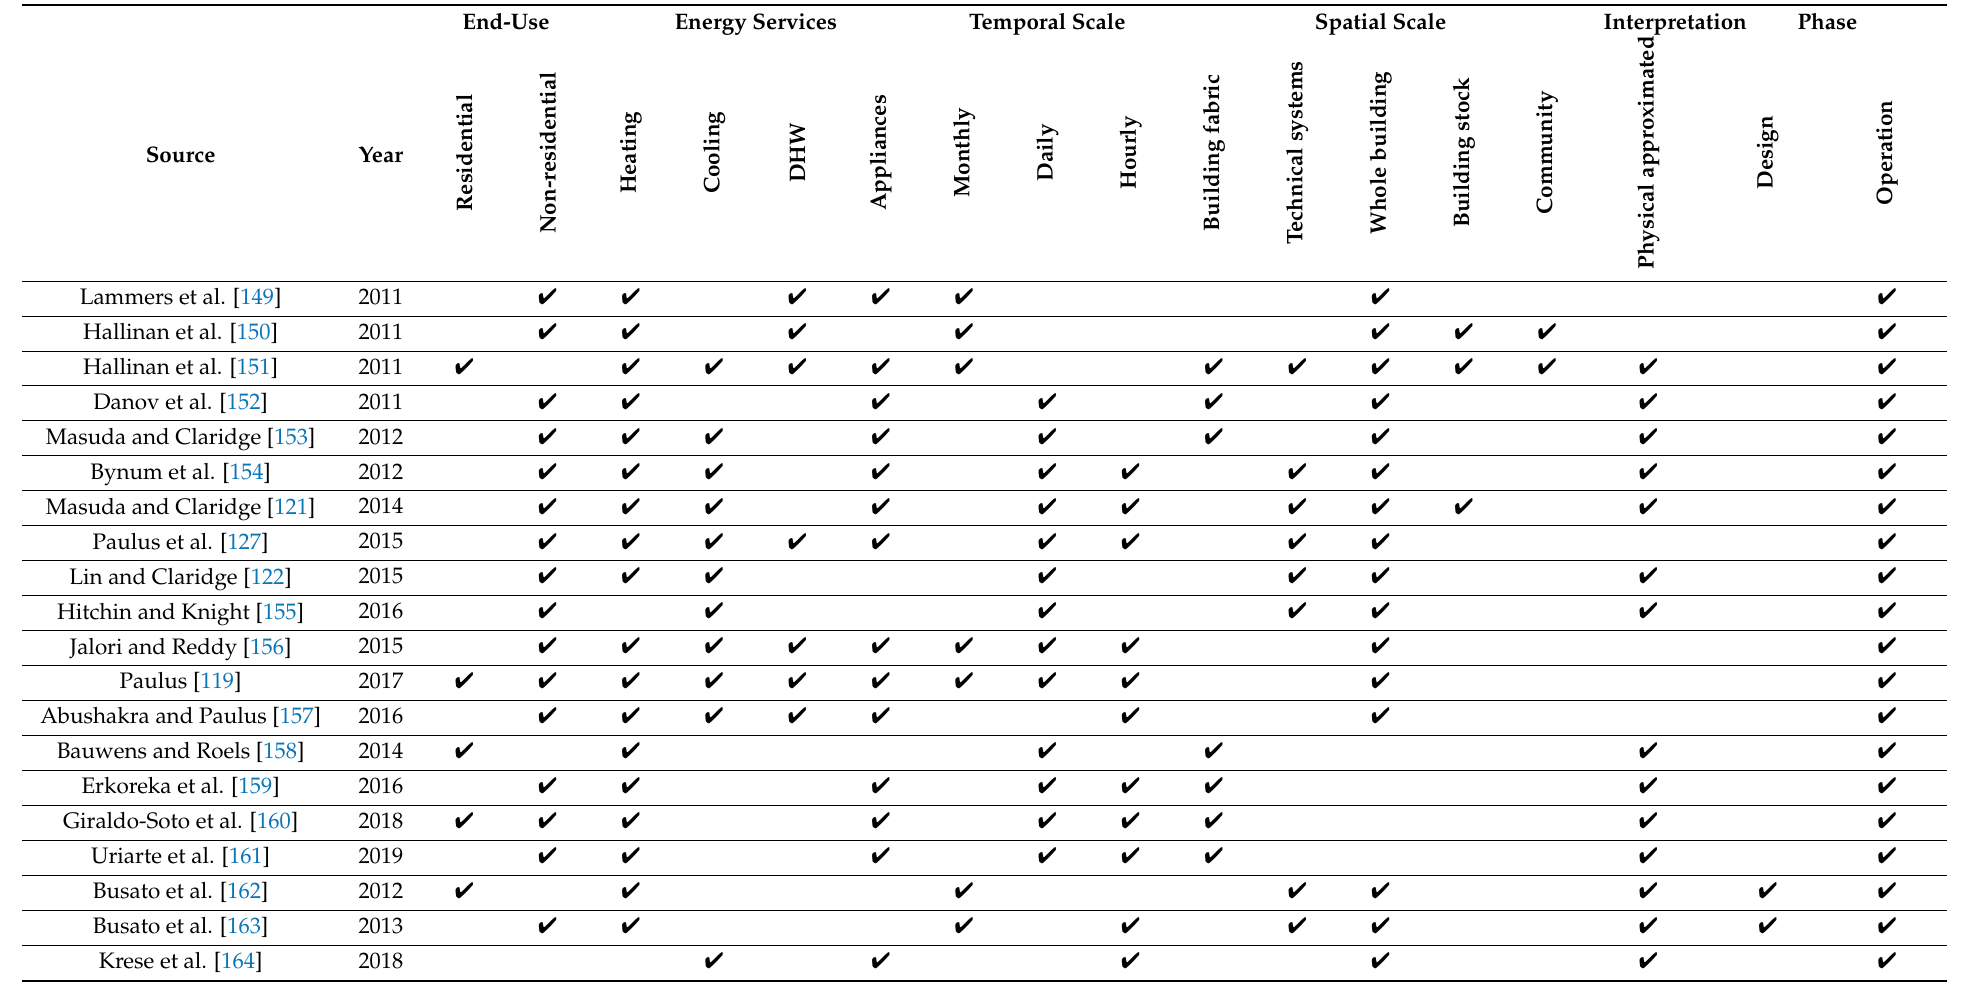
Table 4. Harmonized regression-based modelling approaches for building performance